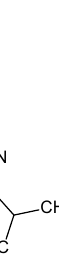
Figure 1. Structures of the investigated heterocycles: 1 . R = H; 2 . R = 4-CH 3 ; 3 . R = 3-Cl; 4 . R = 4-Cl; 5 . R = 3,4-Cl 2 . The particular derivatives differ in the substitution pattern (denoted as R) at the phenyl ring.